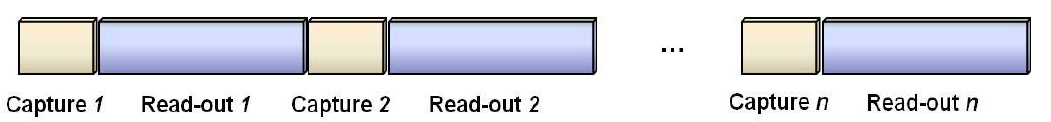
Figure 8. Timing diagram for frame-by-frame video coding using consecutive image coding